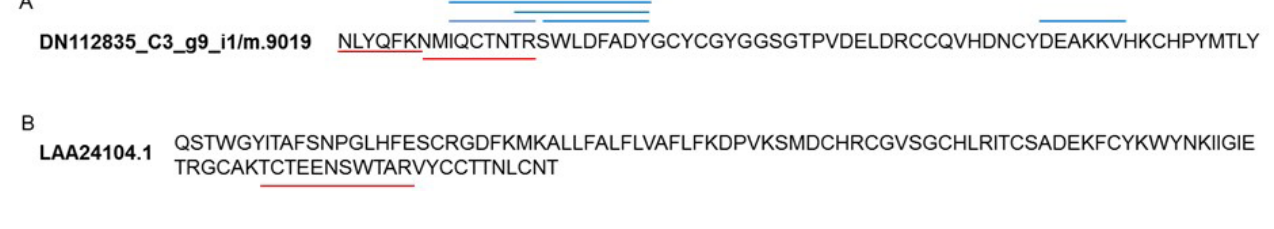
Figure 1. Protein sequences identified in β-micrustoxin. The β-micrustoxin was submitted to an in-solution digestion by chymotrypsin or trypsin enzyme and the proteomic analysis was performed against a proteome database obtained from the venom gland of six Micrurus (coral snakes) taxa. The chymotryptic (blue; upper-line) or tryptic (red; underline) peptides were highlighted. Two protein sequences were identified: (A) the transcript ID DN112835_C3_g9_i1/m.9019 and the sequence (B) LAA24104.